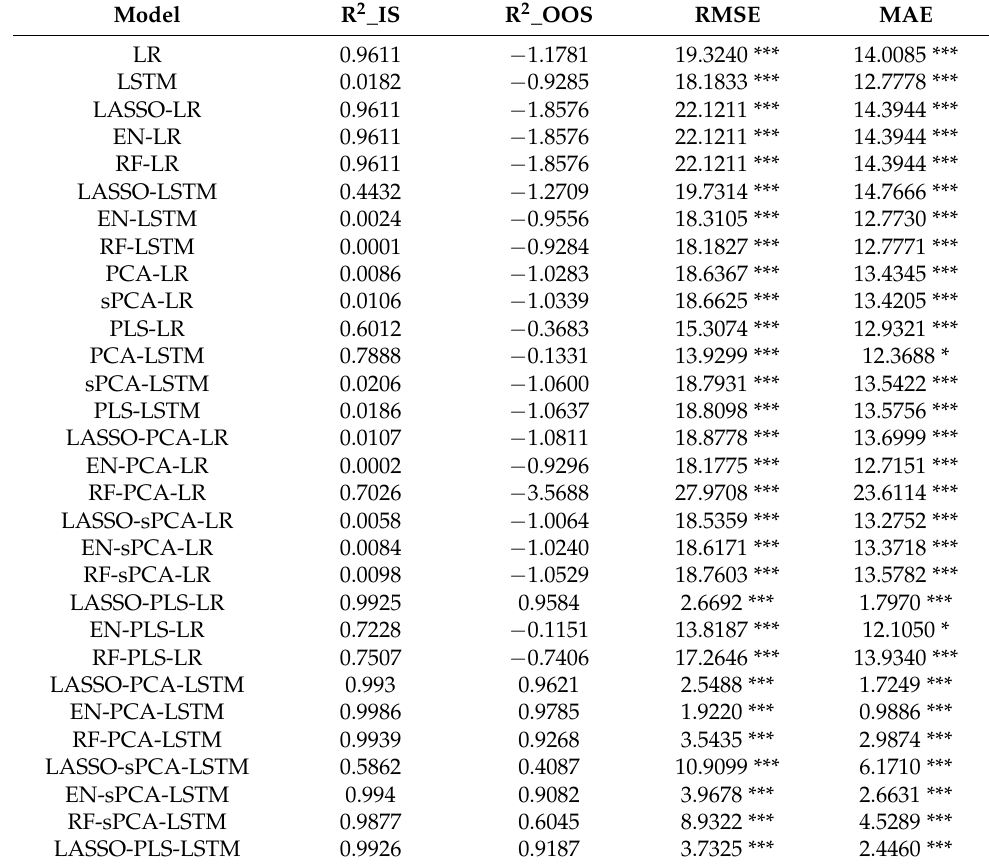
Table 9. Forecast results using normalized